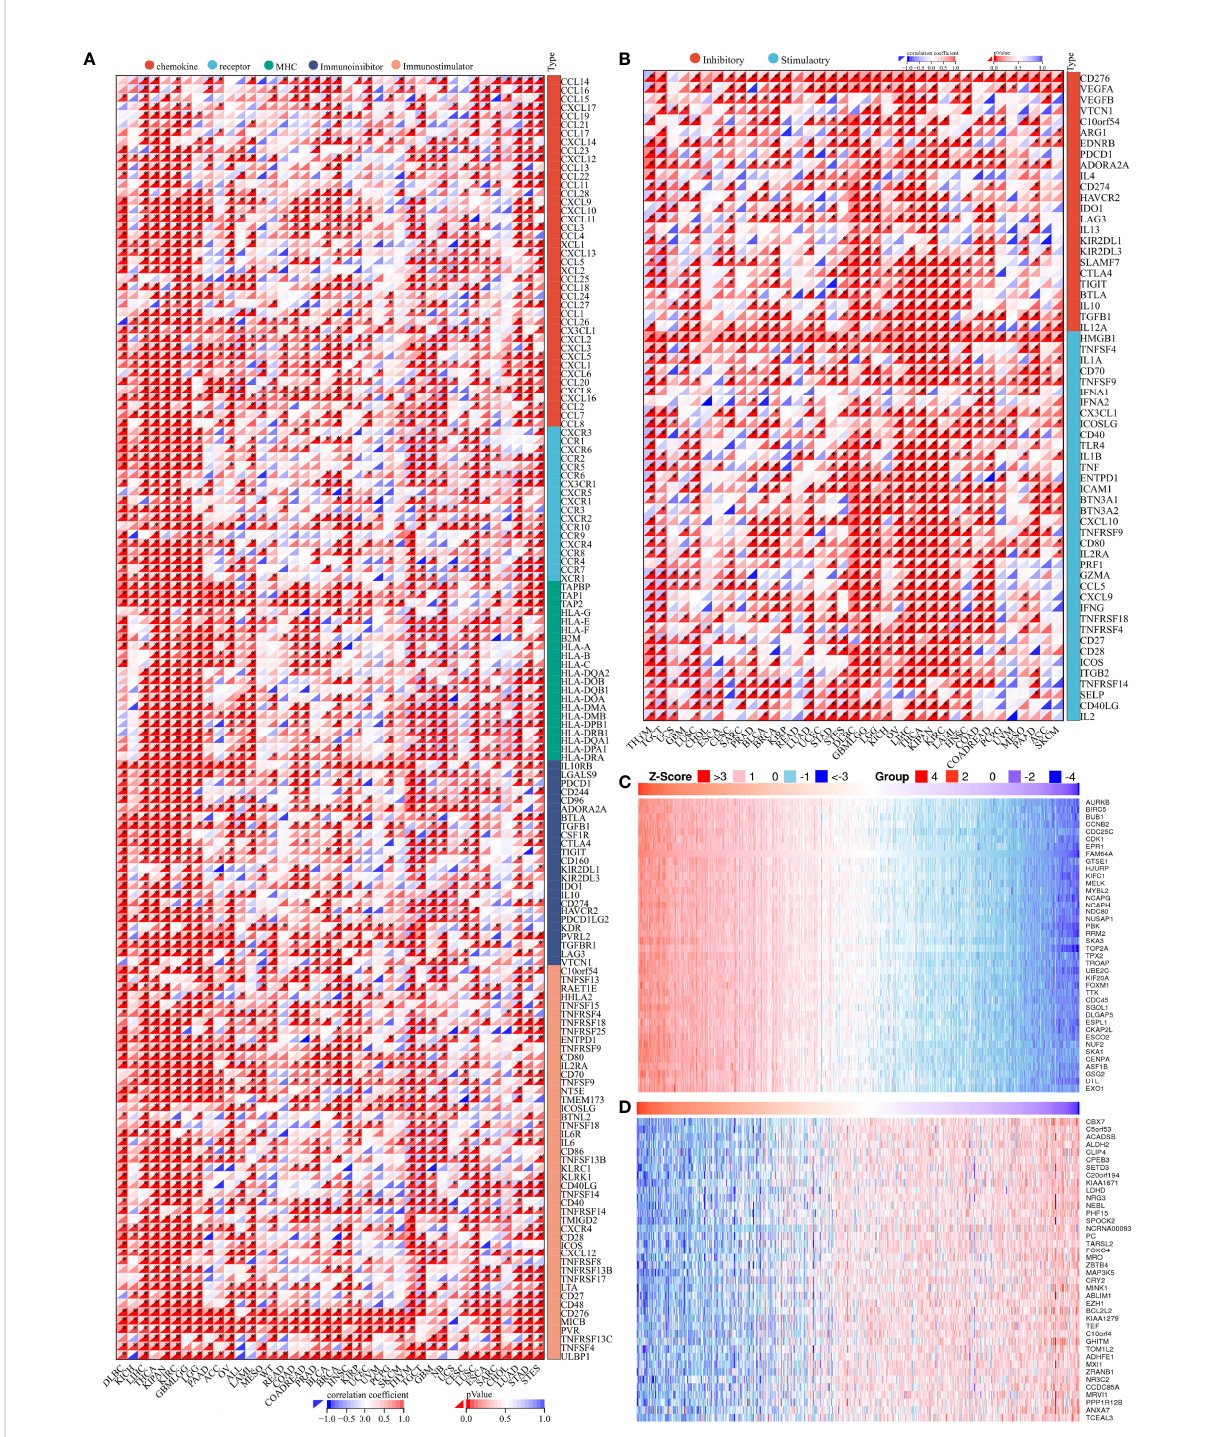
FIGURE 8 Genes coexpressed with PIMREG. (A) Coexpression of PIMREG with immune-related genes. (B) Coexpression of PIMREG with inhibitory and stimulatory immune checkpoints. Signi fi cantly positively (C) and negatively (D) coexpressed genes with PIMREG. * P <